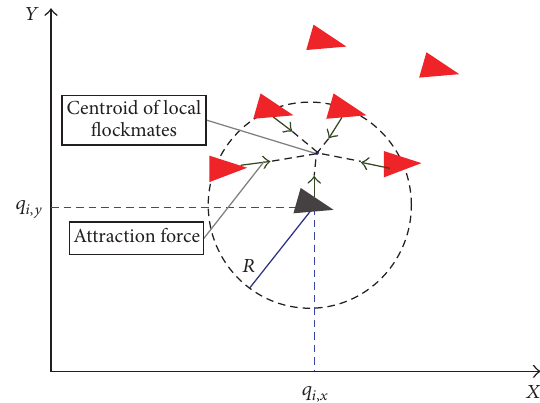
Figure 2: Illustration of an agent disk radius and centroid attraction among the